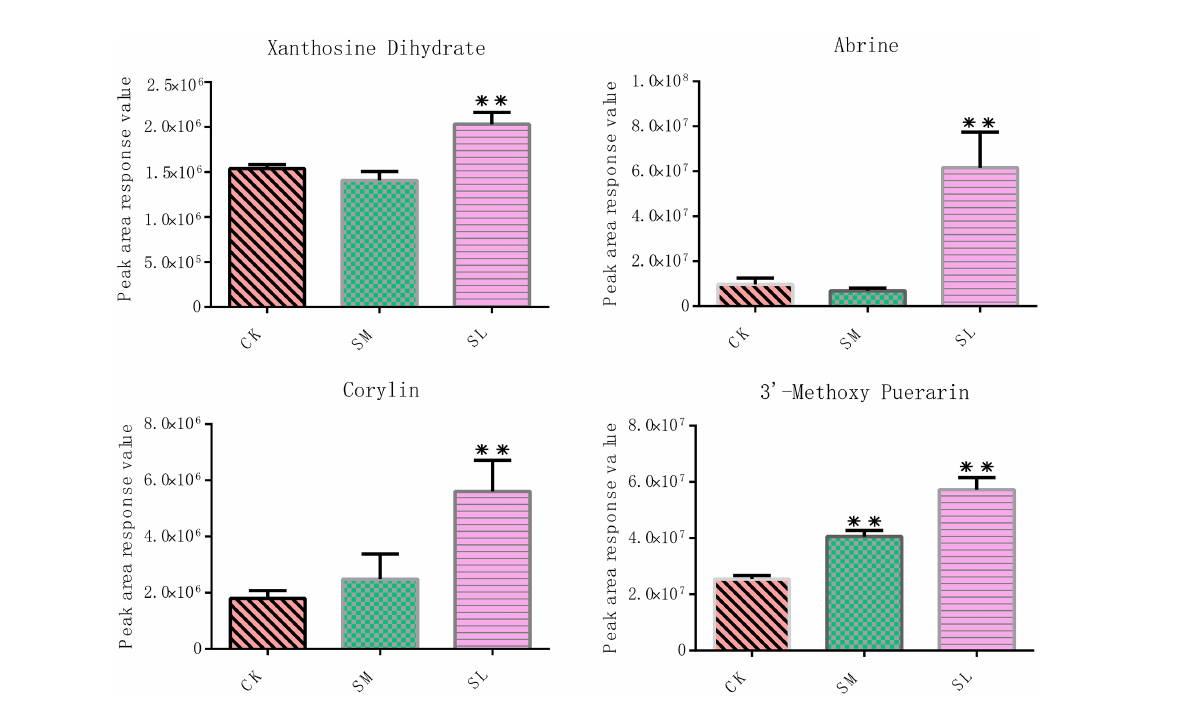
FIGURE 10 Relative contents of four metabolites most strongly correlated with the IibZIP gene regulatory network in leaves of I. indigotica after salt stress treatment. Error bars denote the standard deviation of three replicates (*p < 0.05, **p <